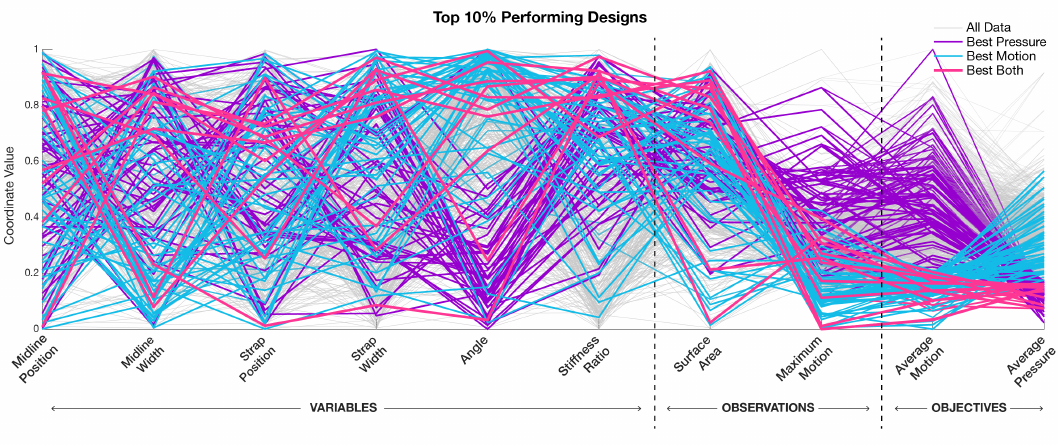
Figure 18. Parallel coordinate plot of variables, observations, and objectives with filtered